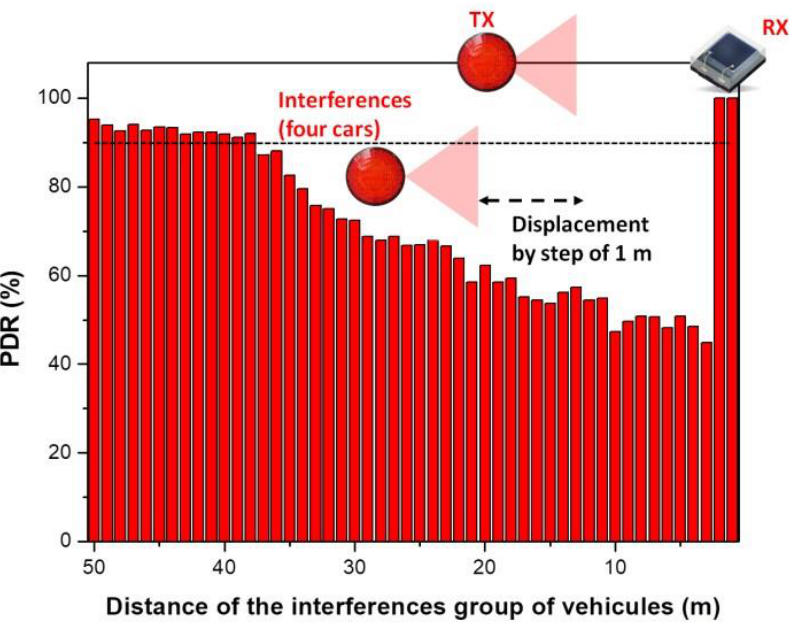
Figure 7. Simulation results showing the packet delivery ratio evolution in a four interference vehicles scenario, for the case when the intended VLC transmitter–VLC receiver distance is decreased at 20 m.